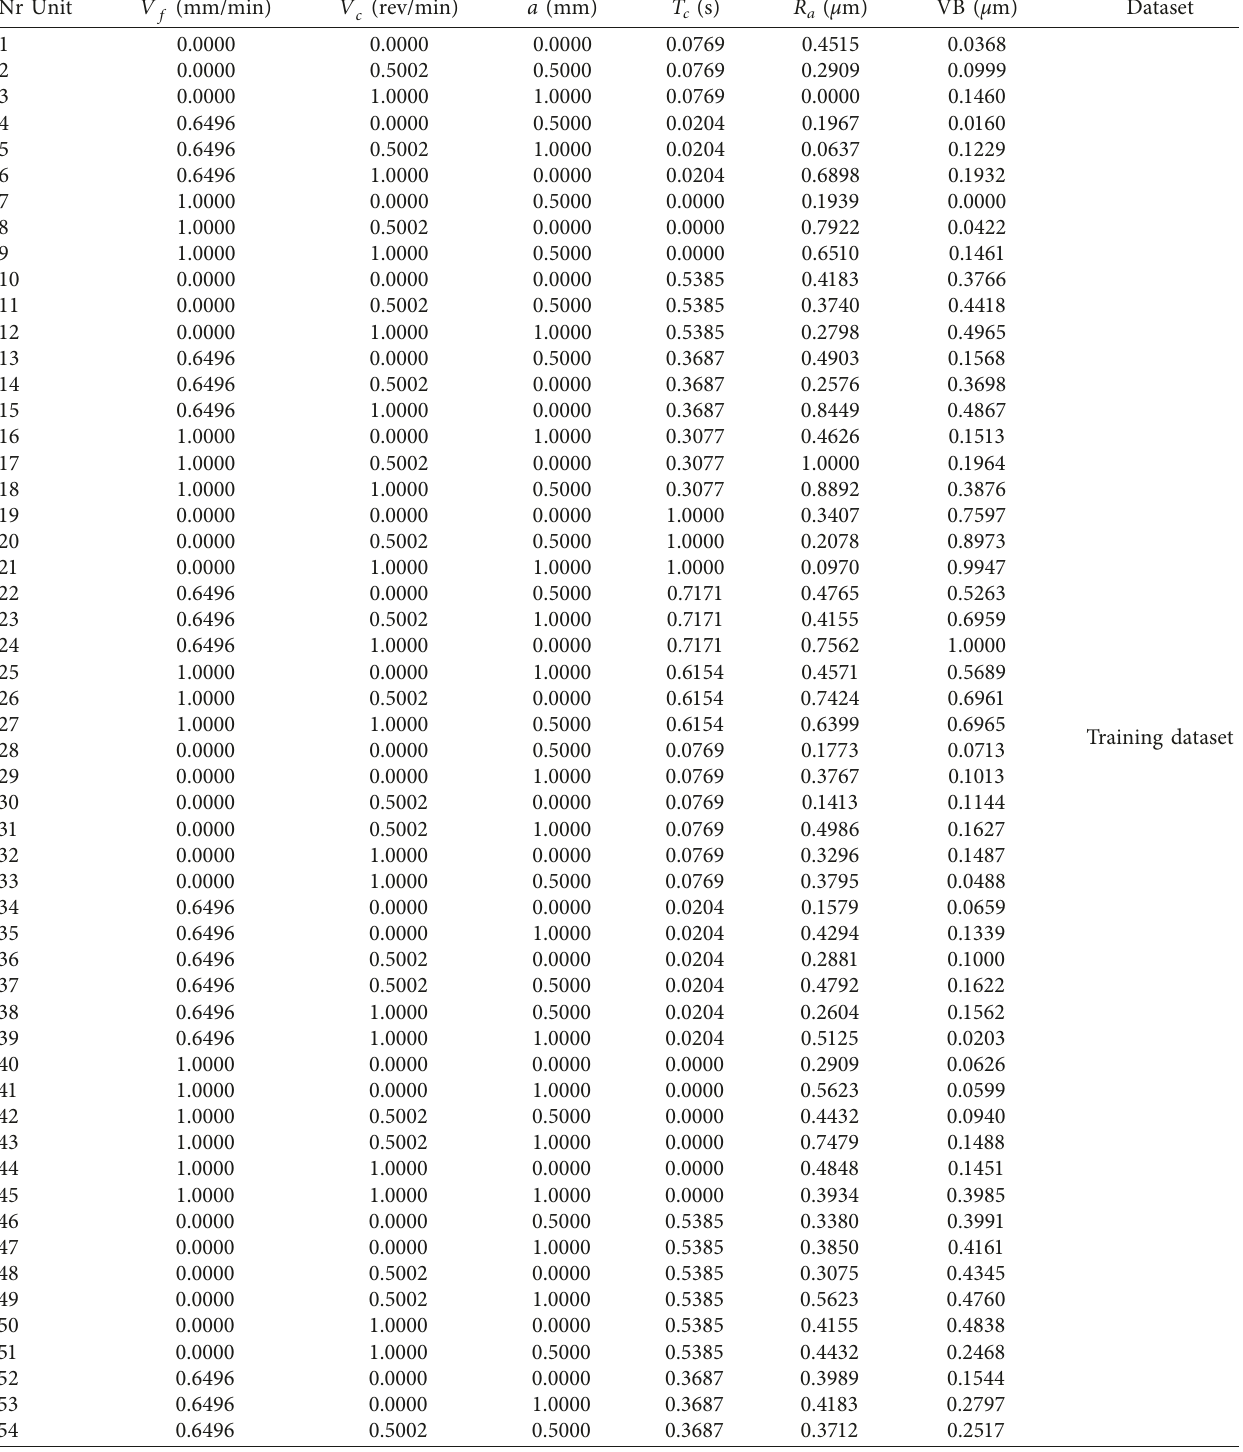
Table 12: Values of variables in the normalized